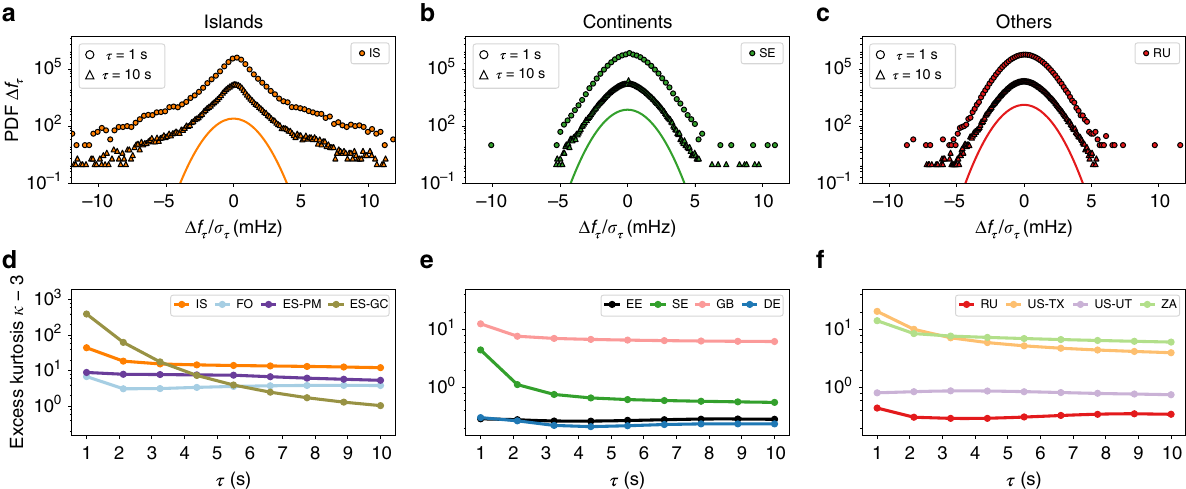
Fig. 4 Increment analysis reveals non-Gaussian characteristics dominantly in islands. a – c We display histograms of the increments Δ f τ for the lag values τ = 1, 10 s for selected areas. The curves are shifted for visibility and compared to a Gaussian distribution as reference. a Iceland (IS) displays clear deviations from Gaussianity, even for larger increments τ . b The Nordic area (SE) displays a non-Gaussian distribution for τ = 1 s, but approaches a Gaussian distribution for larger delays τ . c Russia (RU) has a Gaussian increment distribution for all lags τ . d – f We plot the excess kurtosis κ − 3 for the different examined power-grid frequency recordings on a log-scale. We observe a non-vanishing intermittency in Gran Canaria (ES-GC), Iceland (IS), Faroe Islands (FO), Mallorca (ES-PM), Britain (GB), Texas (US-TX), and South Africa (ZA). In contrast, the increments ’ distribution of the Baltic (EE), Continental Europe (DE), Nordic (SE), Russia (RU) synchronous areas, and the Western Interconnection (US-UT) approach a Gaussian distribution. See also Fig. 5 for an illustration how increments are computed from a